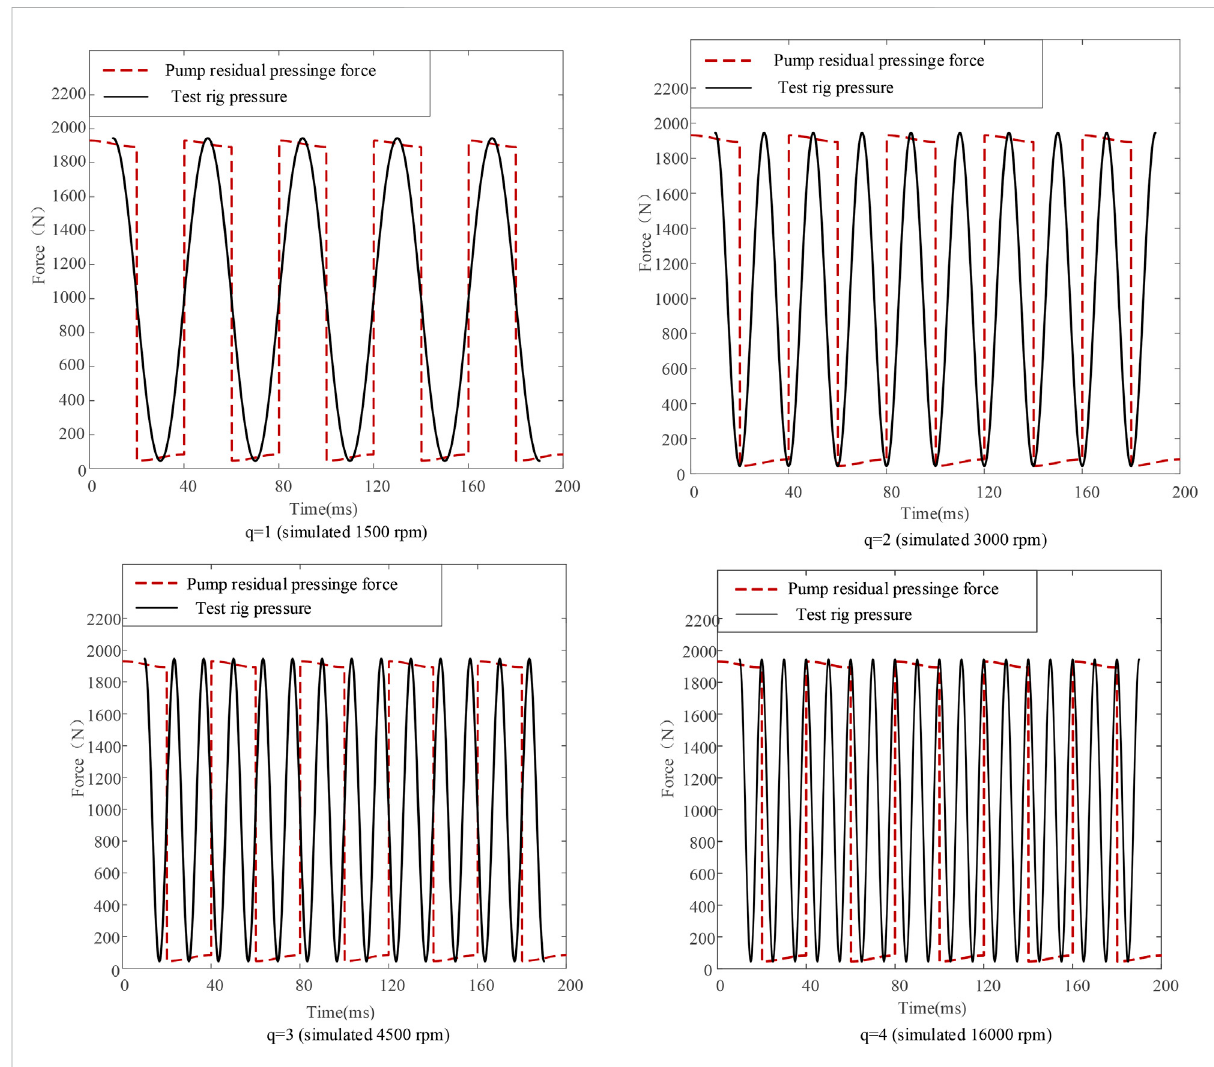
FIGURE 13 High-speed simulation results of the test